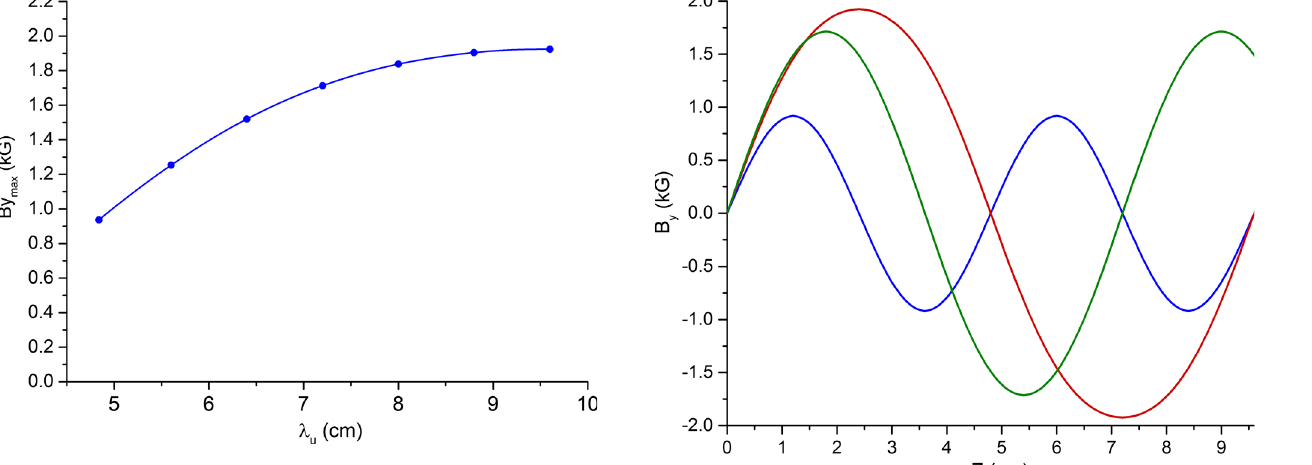
FIG. 6. Dependence of field amplitude on undulator period.